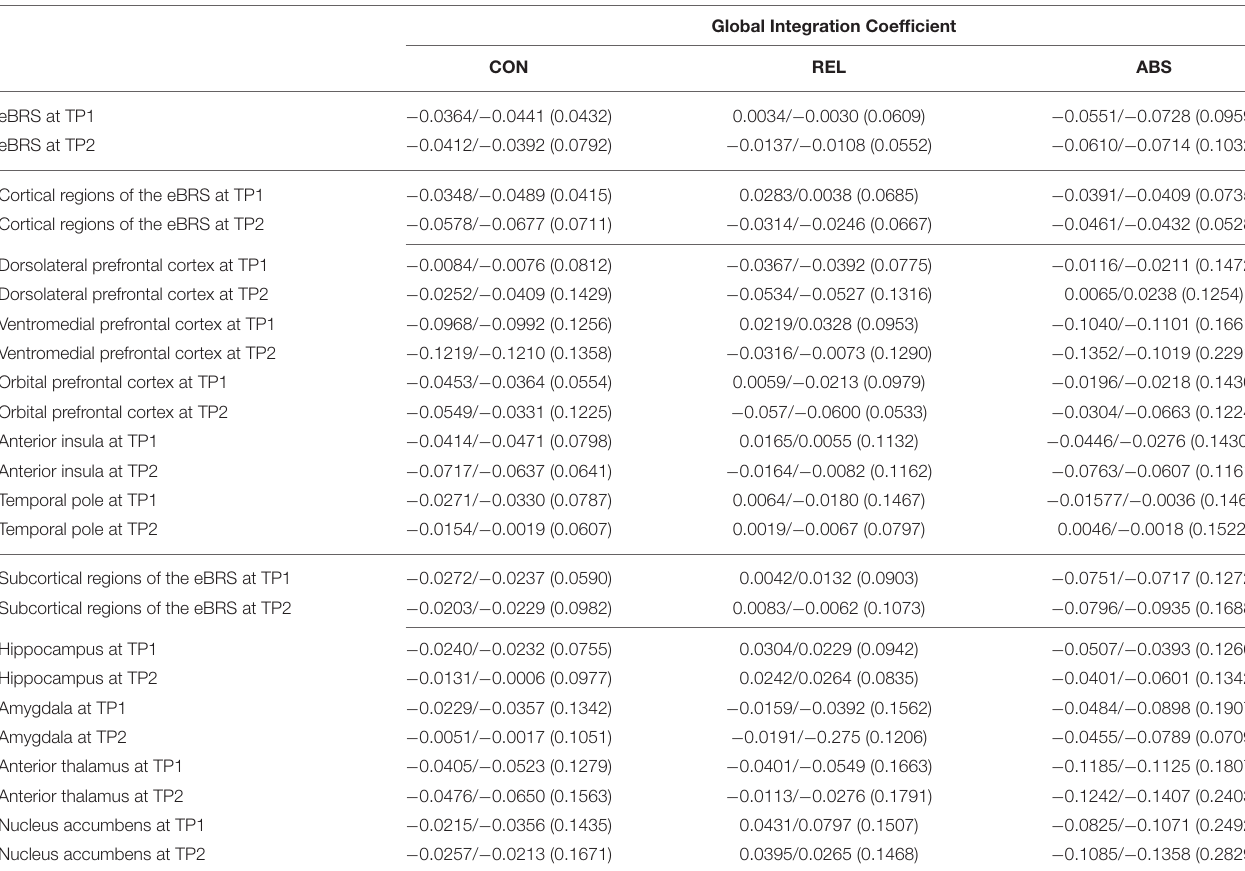
TABLE 3 | The global integration coefficient of the extended brain reward system (eBRS) and its constituent brain regions for the controls (CON), relapsers (REL), and abstainers